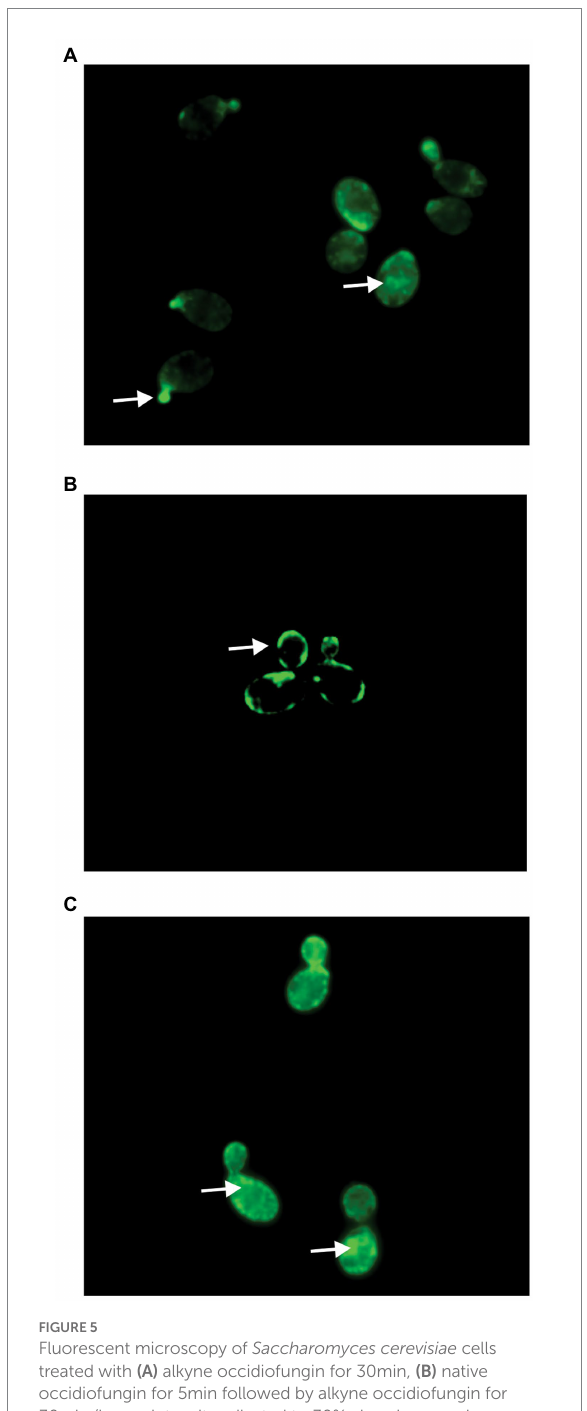
FIGURE 5 Fluorescent microscopy of Saccharomyces cerevisiae cells treated with (A) alkyne occidiofungin for 30 min, (B) native occidiofungin for 5 min followed by alkyne occidiofungin for 30 min (image intensity adjusted to 30% given increase in nonspecific binding to cell envelope), (C) dodecylamine analog for 5 min followed by alkyne occidiofungin for 30 min. Green fluorescence indicates location of alkyne occidiofungin. White arrows demarcate specific locations of alkyne-OCF at bud tips, intracellular inclusions or at the cell